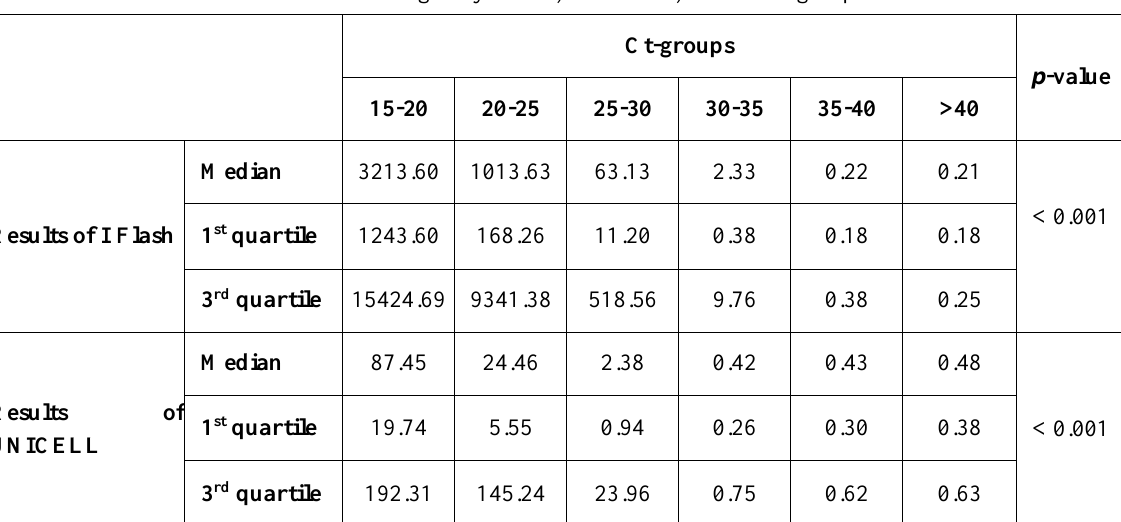
Table 3. The relation between level of antigen by iFlash, UNICELL, and the